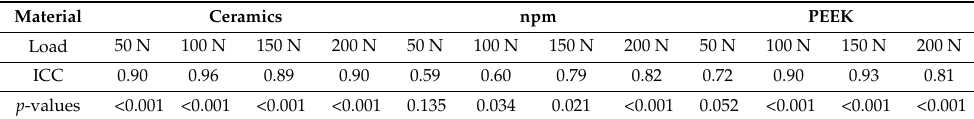
Table 2. p -values of the equivalence tests and intraclass correlation coefficients (ICC) for the optical measurement method and strain gauge 1.